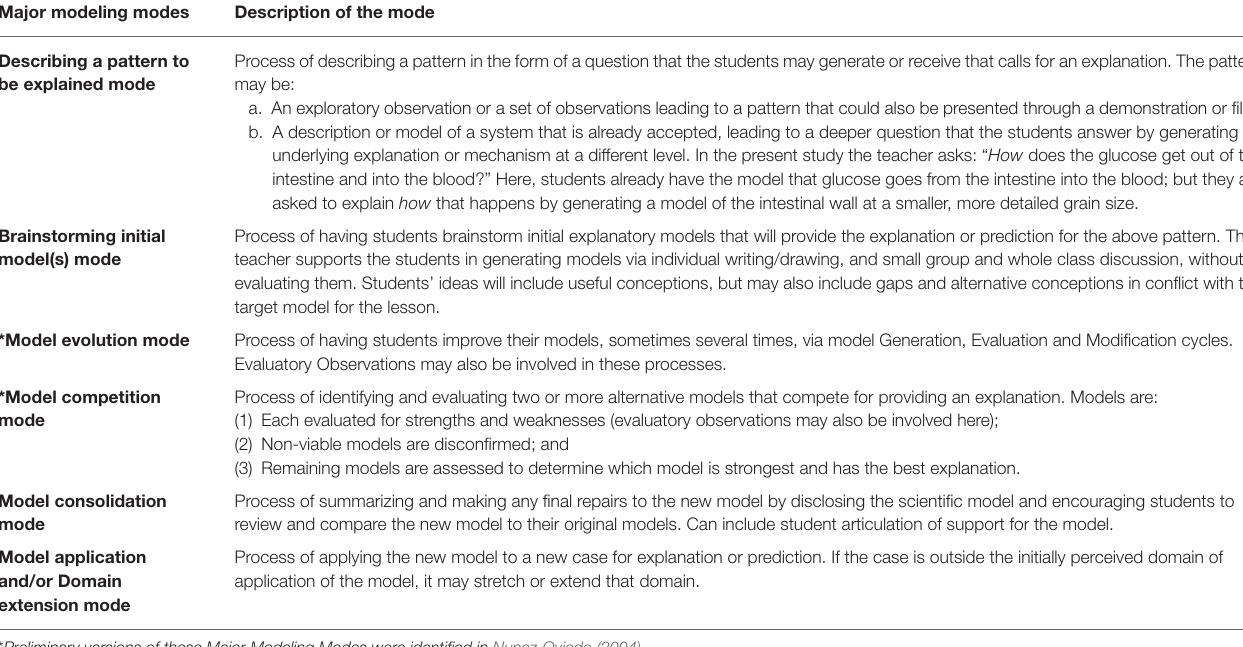
TABLE 1 | Major modeling modes.